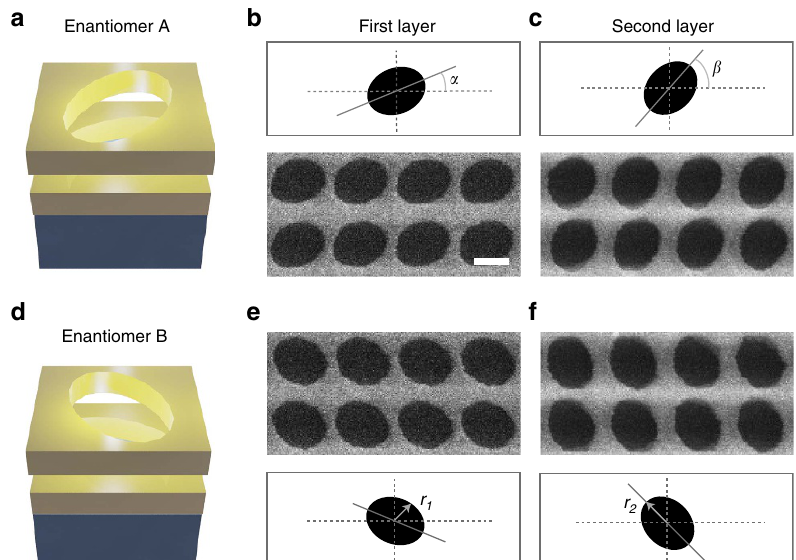
Figure 1 | Schematic and micrographs of chiral metamaterial enantiomers. ( a ) A single unit cell of the metamaterial array. The nanoengineered material is composed of two silver films separated by 45nm of a dielectric spacer ( n ¼ 1.45) and perforated with two ellipses, where the major axes of the ellipses are skewed by 22.5 (cid:2) . ( b ) The SEM image depicts the first layer of the structure and is followed by an image of the ( c ) upper layer placed on top of the first. The scale bar in the image is 200nm and the overall pitch of the unit cell is 350nm. The characteristic parameters of these ellipses are r 1 ¼ 115nm, r 2 ¼ 150nm and a ¼ 22.5 (cid:2) , b ¼ 45 (cid:2) from the coordinate axis. The second unit cell on the lower half of the figure is then created by aligning the ellipses such that the unit cells are mirror images of each other known as enantiomers. ( d ) Schematics and SEM images of the ( e ) lower and ( f ) upper layers of enantiomer B are